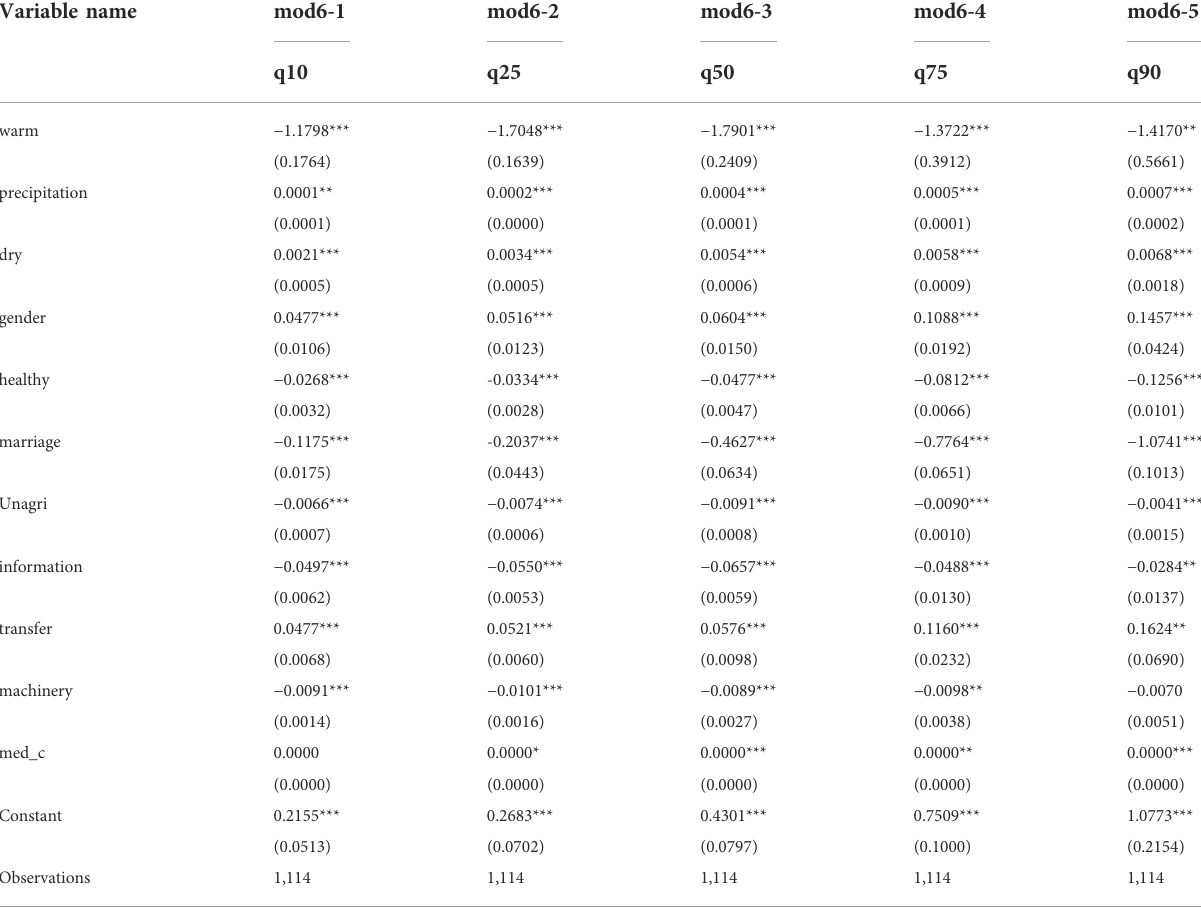
TABLE 6 Impact of extreme weather on farm households with different levels of poverty vulnerability (poor = RMB